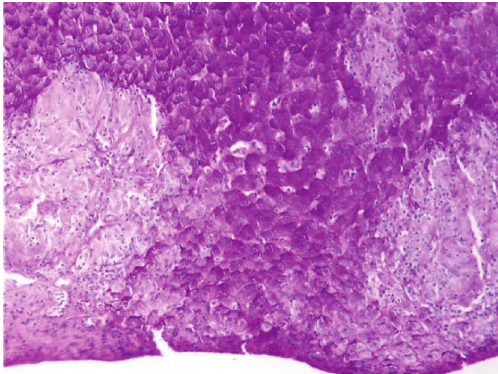
Figure 1: Nonnecrotizing granulomas of hepatic sarcoidosis.